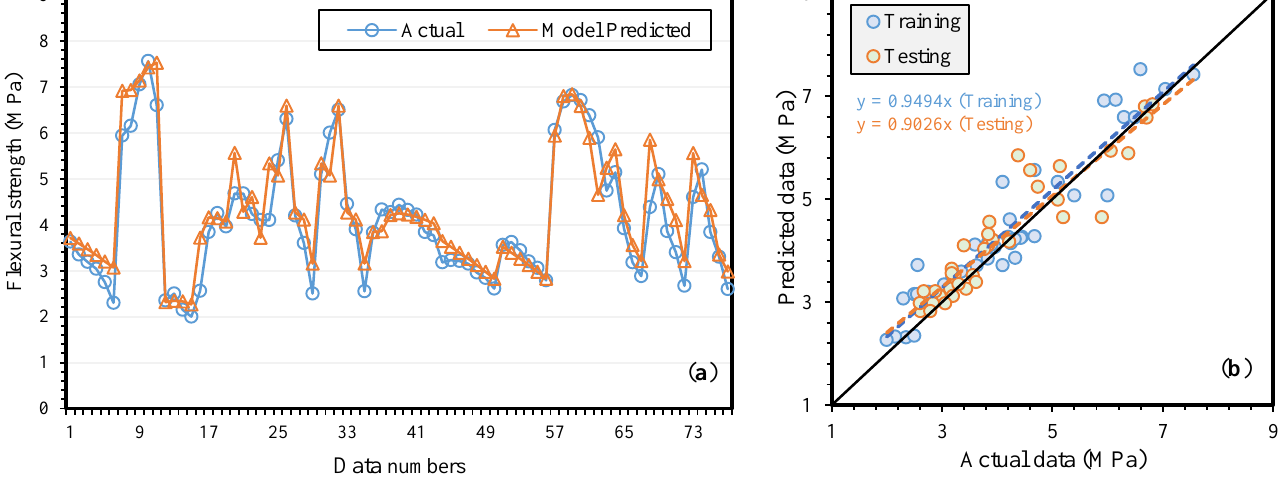
Figure 5. Comparison of actual and model predicted flexural strength ( a ) variation in data ( b ) scattered plot.